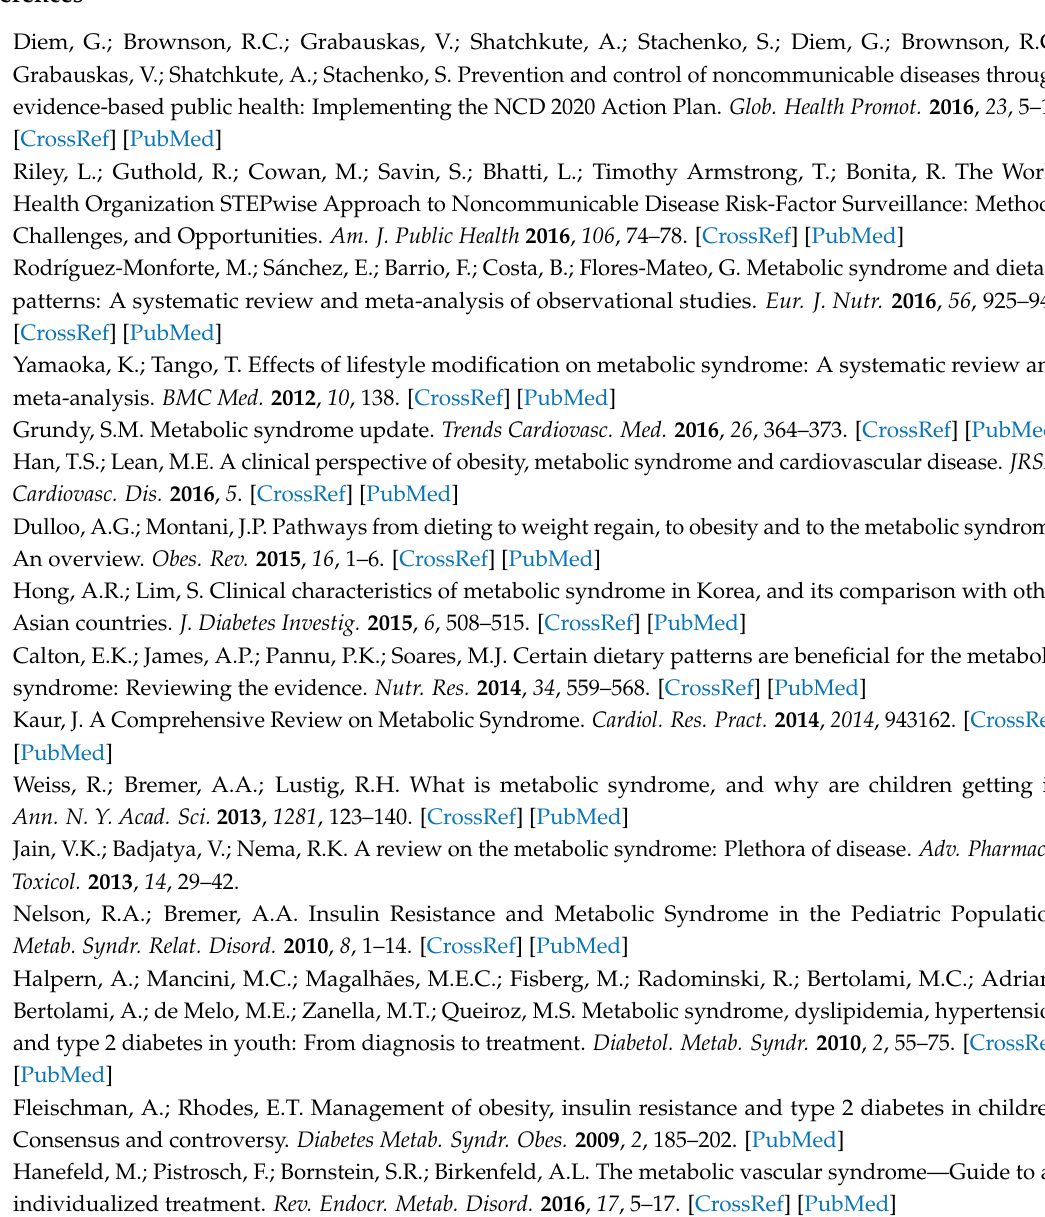
Table S1: PRISMA 2009 Checklist (63)